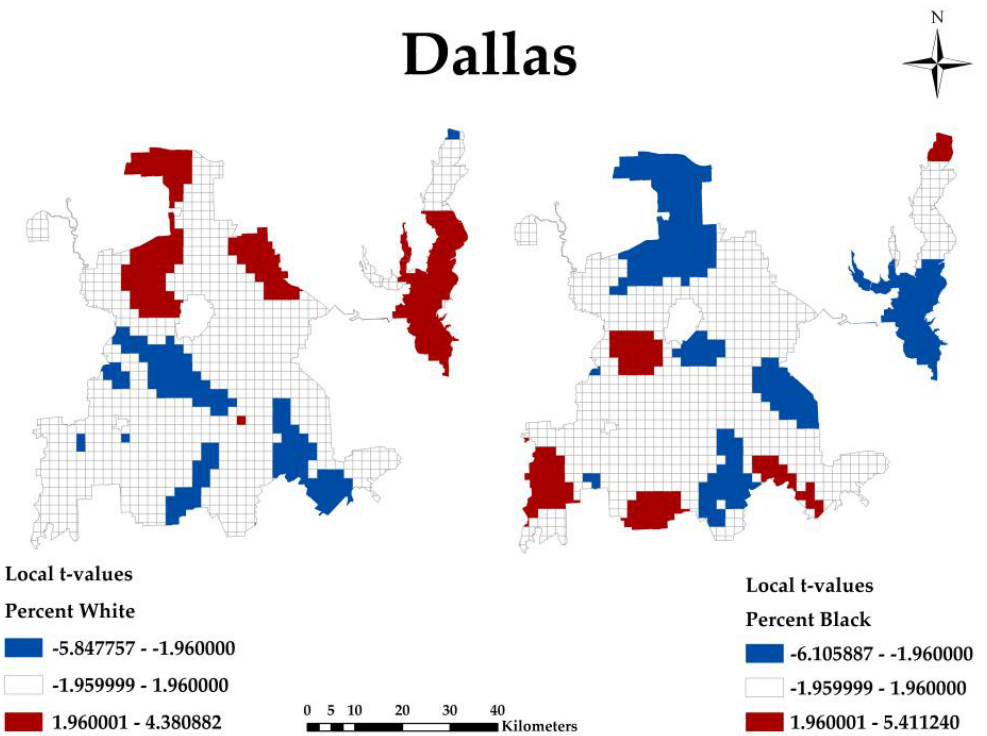
Figure 14. Dallas growing city Percent White and Percent Black: 95% two-tailed test (−1.96:1.96).